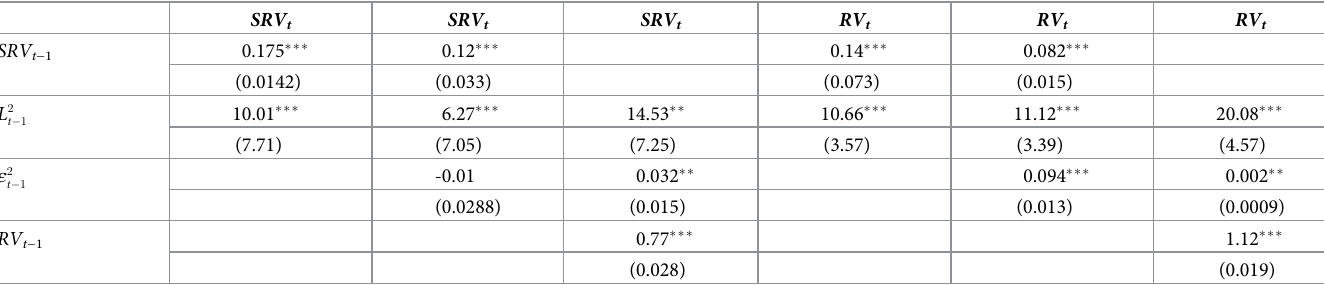
Table 2. Regression results summary for simplified realized variance and realized variance.